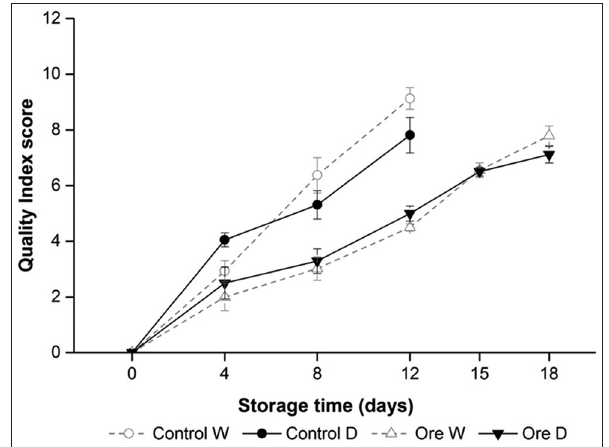
Figure-1: Sensory assessment of raw dark (D) and white (W) muscle from frigate tuna fillet during the refrigerated storage under vacuum pack: Untreated (Control), Oregano extract (Ore). Mean scores of sensory assessment (n=6). Standard deviations are indicated by bars.